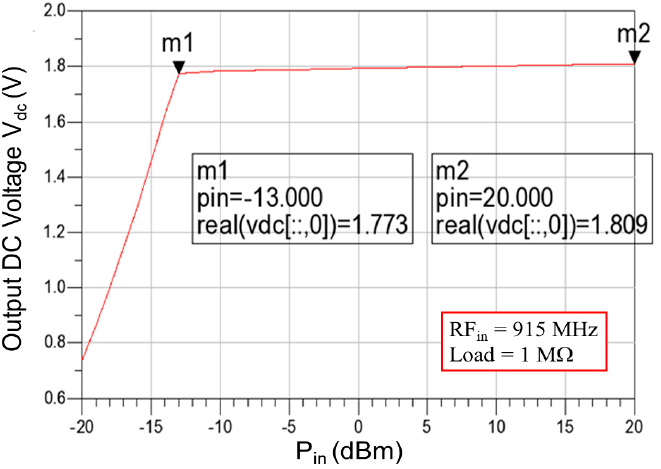
Figure 10. Simulated DC output voltages of the RF-DC rectifier with over-voltage protection.